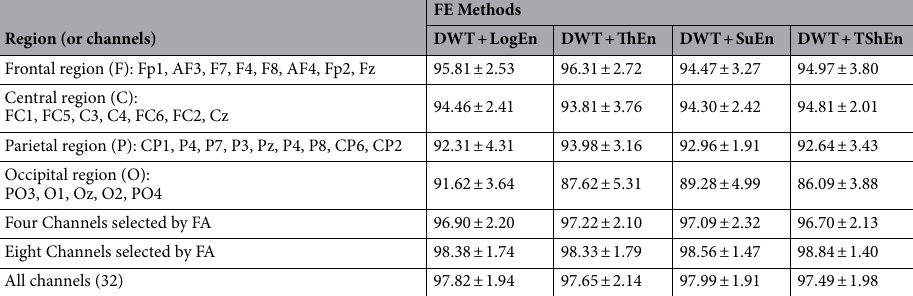
Table 9. Classification results of off-PD versus on-PD using KNN classifier.